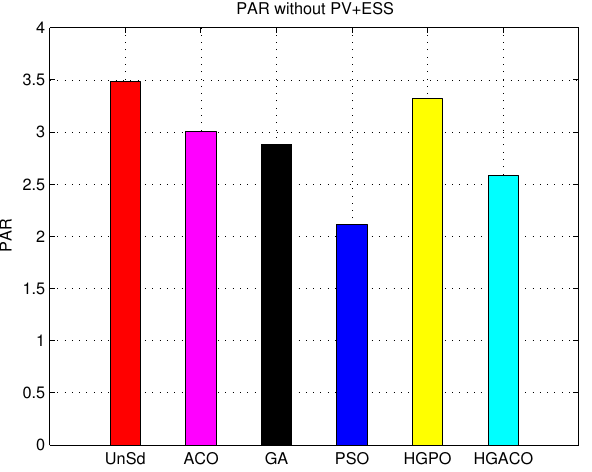
Figure 11. Peak to Average Ratio (PAR0 without photovoltaic-battery systems. Table 7. Scenario I: PAR assessment without photovoltaic-battery